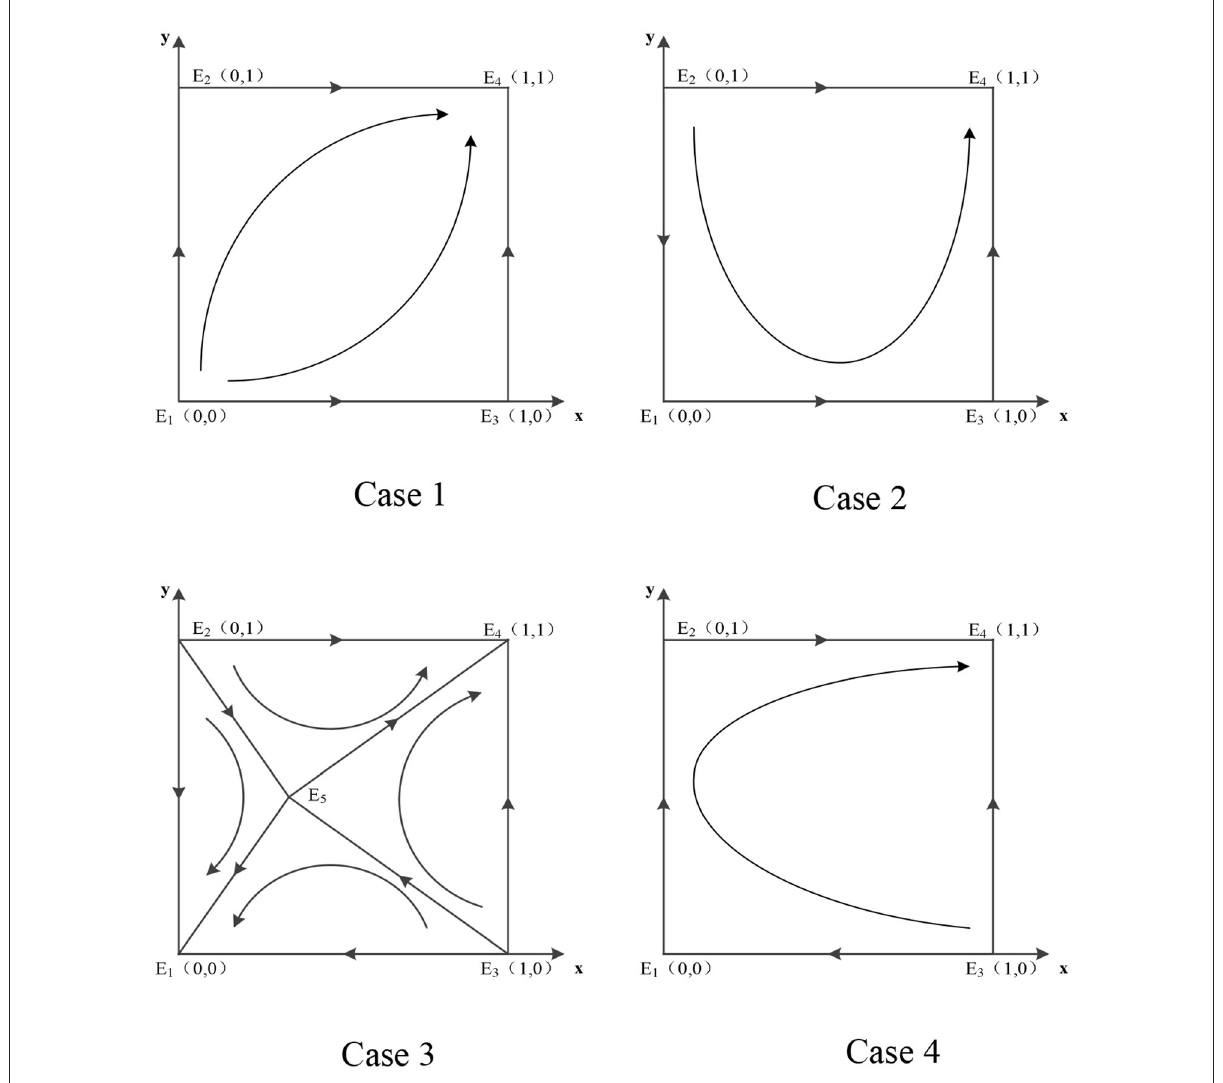
FIGURE1 Evolutionary phase diagram of the system under different